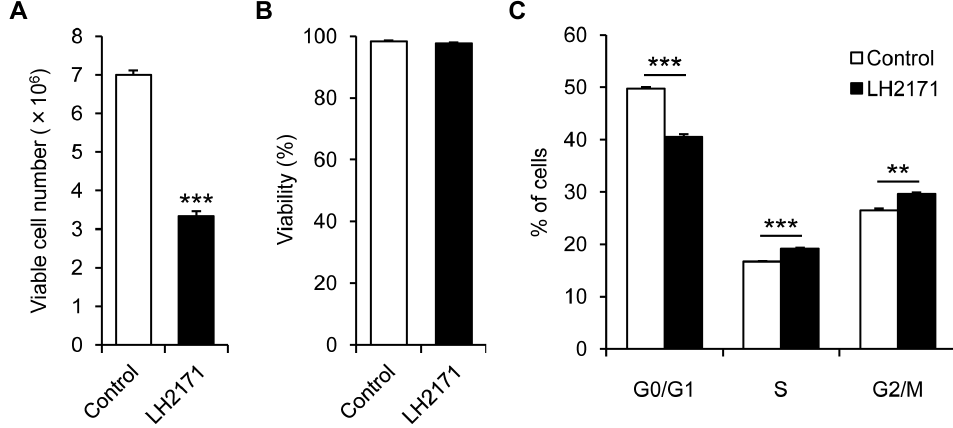
Figure 3. LH2171 inhibited the cell cycle progression in BJAB cells. BJAB cells were cultured in the presence or absence of Lactobacillus helveticus SBT2171 (LH2171) (100 m g/mL) for 72 hours. After cultivation, viable cell number (A) and viability (B) were calculated by trypan blue dye exclusion assay, and cell cycle (C) was analyzed by propidium iodide (PI) staining. Data are expressed as means 6 SEM (n=3) and compared with the control (** P , 0.01, *** P , 0.001) by Student’s t -test.